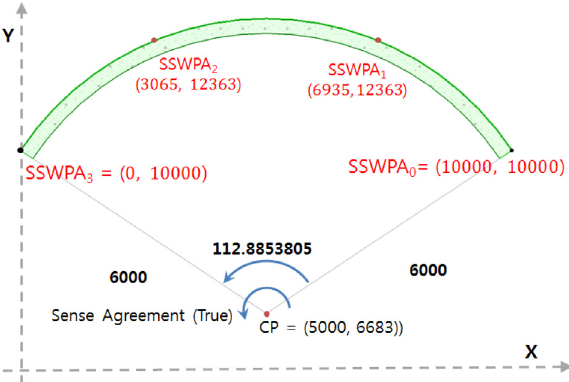
Fig. 15. Created SSWPA